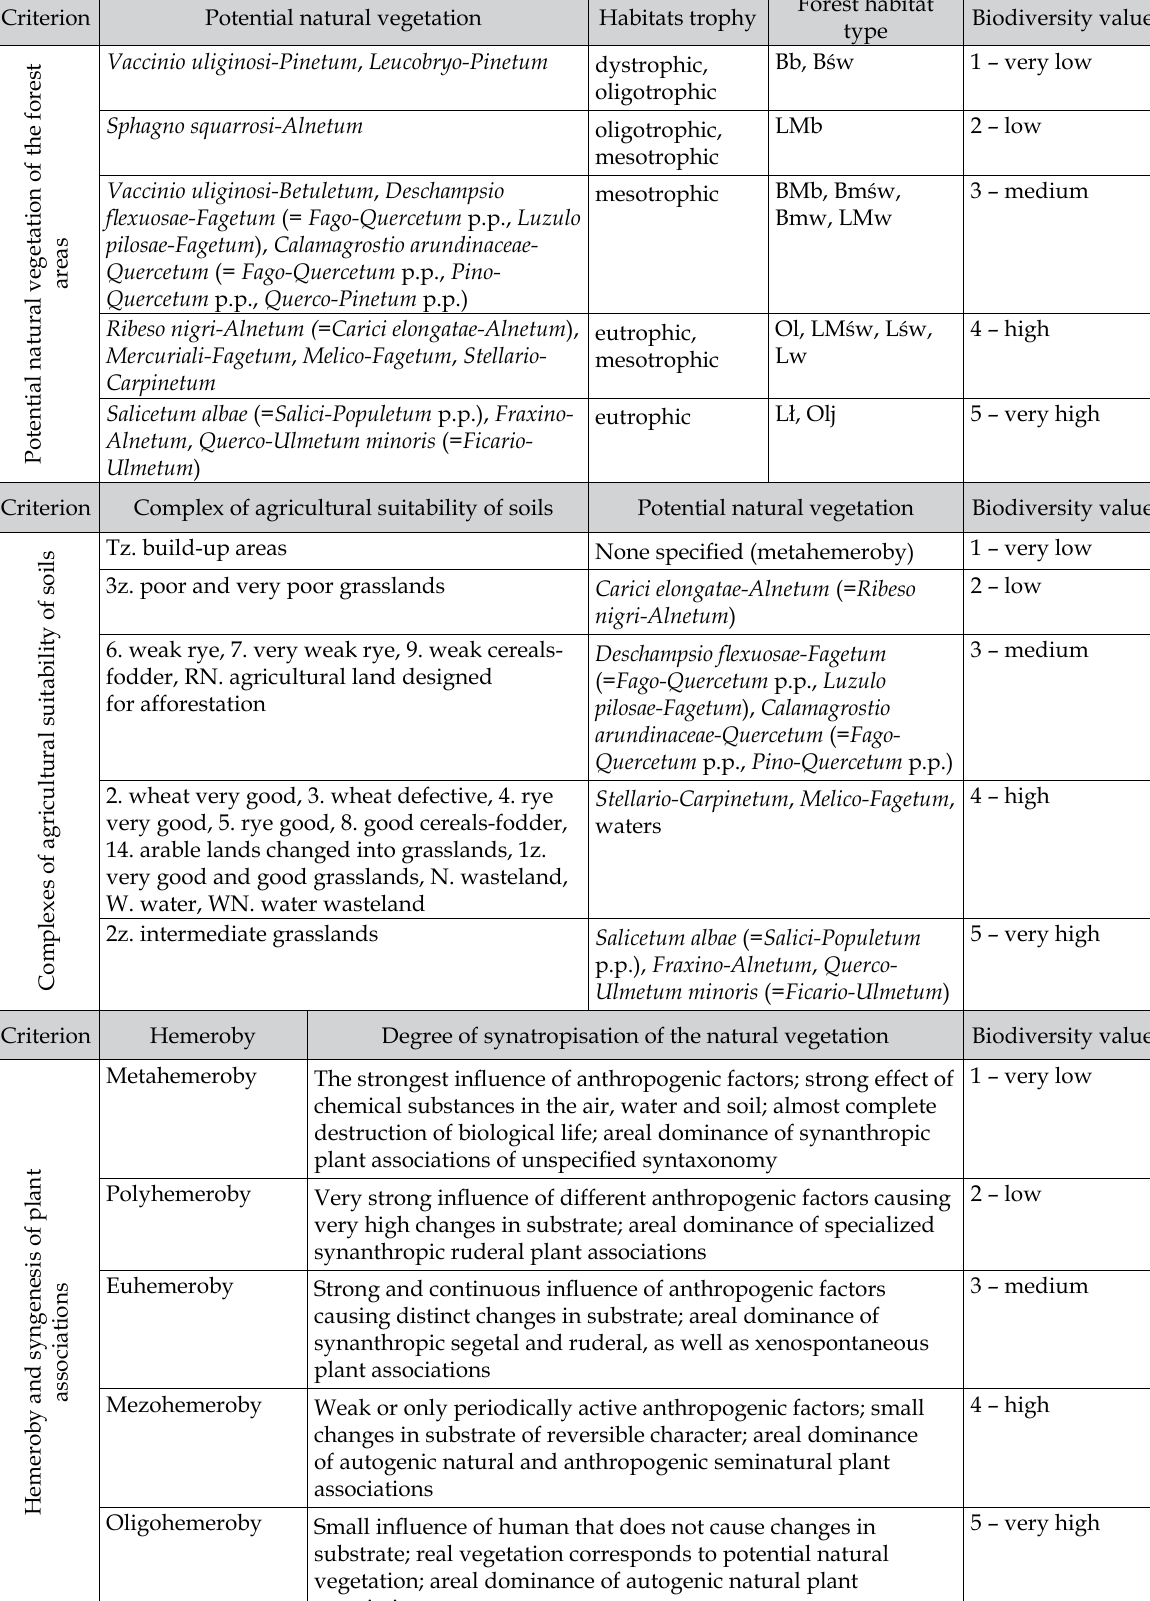
Table 2. The criteria for the assessment of biodiversity values for particular factor